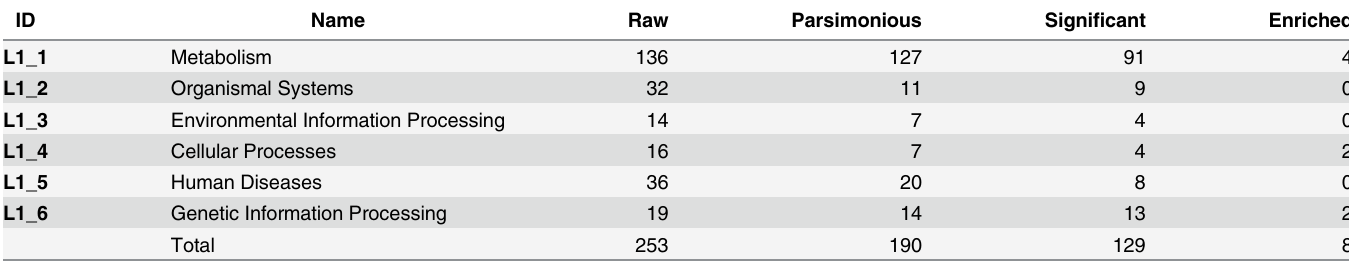
Table 3. Number of biochemical pathways by pathway supergroup.